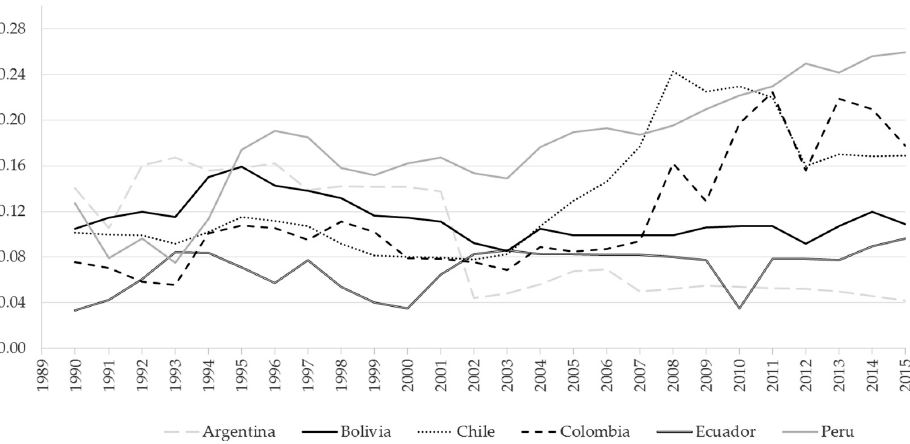
Figure 4. Average annual price of electricity in the commercial and services sector. Source: Energy Information System of Latin America and the Caribbean (sieLAC) of the Latin American Energy Organization (OLADE) [41].